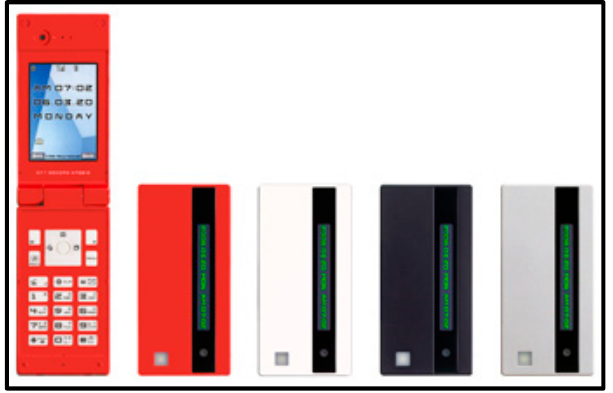
Figure 8. First mobile phone using a casing made of natural fiber